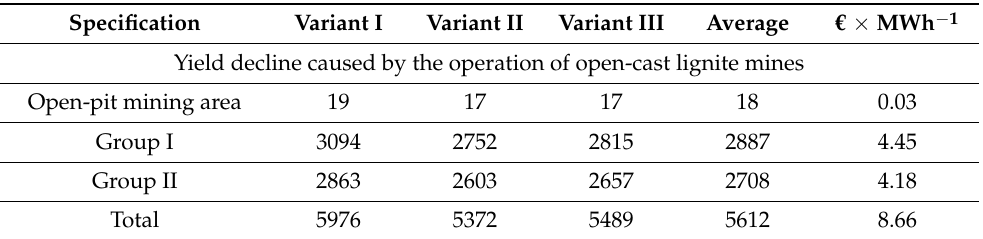
Table 5. External costs related to the exploitation of lignite in the Konin-Turek Basin, in the period 1961–2060 ( €